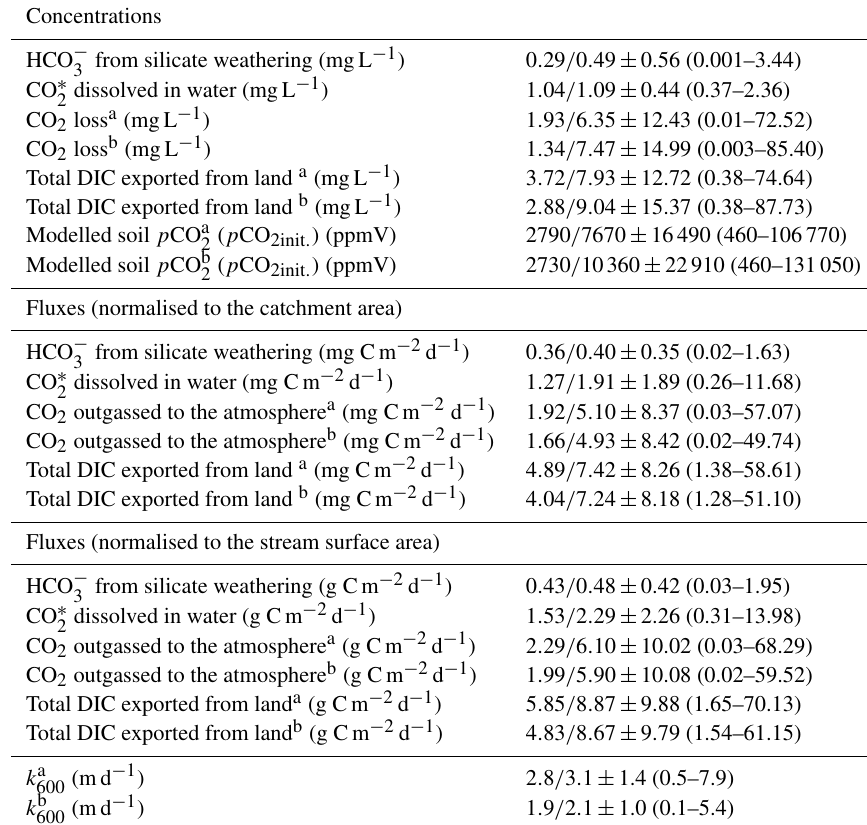
Table 3. DIC partitioning according to the streamCO 2 -DEGAS model (Polsenaere and Abril, 2012) and calculated from DIC measurements from September 2014 to April 2016 in the Uhlíˇrská catchment expressed as median/average values ± 1 σ standard deviation and ranges given in parentheses. The total DIC export corresponds to the sum of HCO − calculated from DIC init . , pH and temperature. k 600 was calculated from model